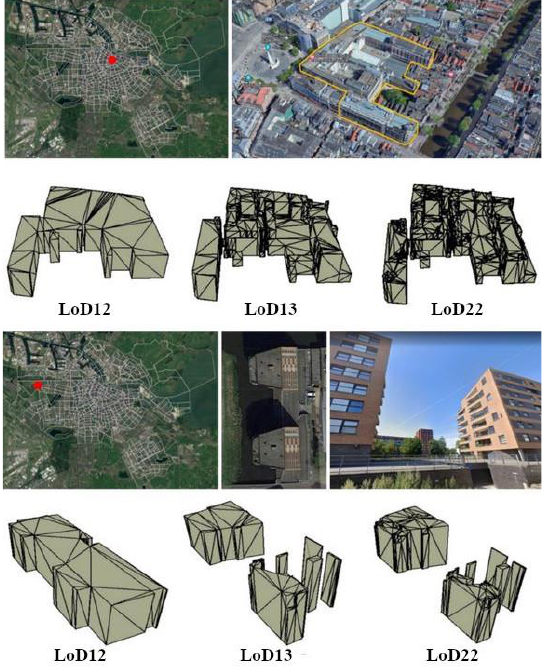
Figure 8. Examples of multi-part buildings: [top] a correctly reconstructed building, [bottom] a wrongly reconstructed building. Figure 9. Distribution of volume differences (in %) between LoD22 and nDSM models based on footprint size. Top and bottom whiskers correspond to the 95 th and 5 th percentile,